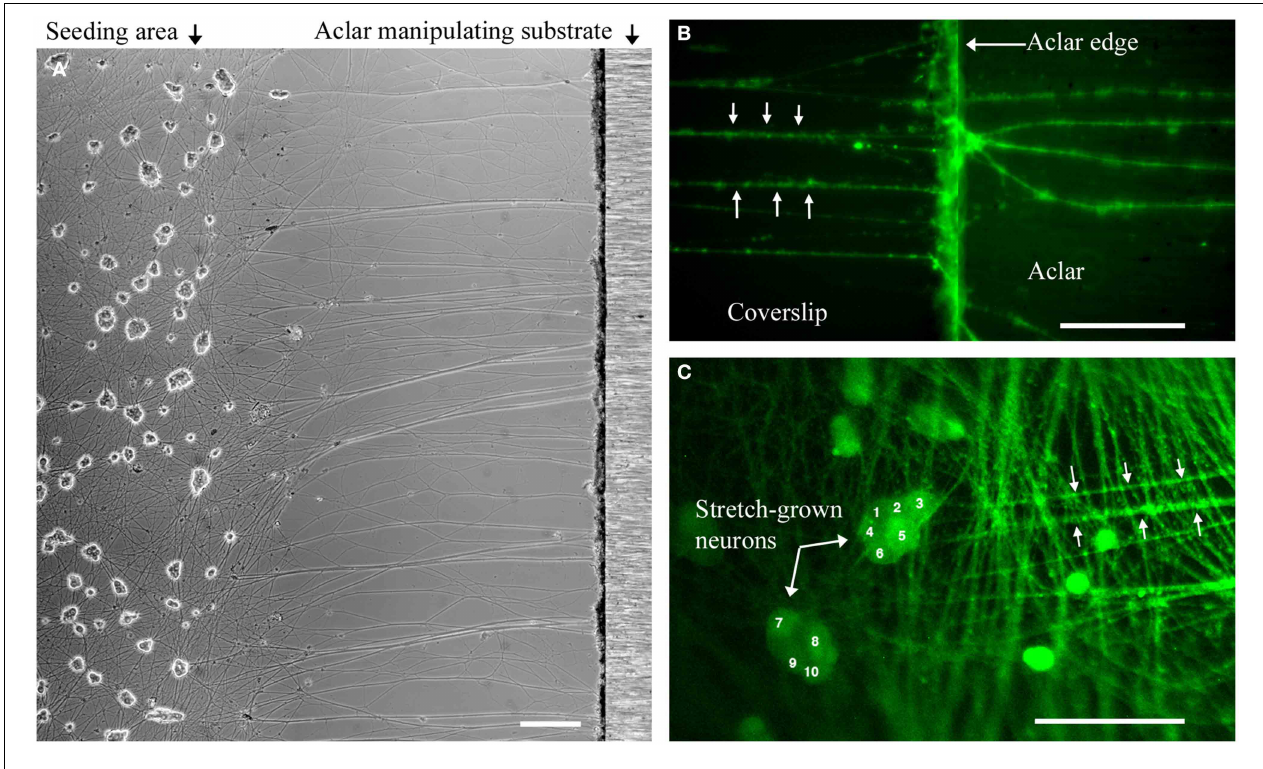
FIGURE 3 | Dissociated stretch-grown neurons. (A) Stretch-grown neurons following 1mm stretch-growth, bar = 250 μ m. (B) Neurons stained with Fluo-4AM were traced from the Aclar manipulating